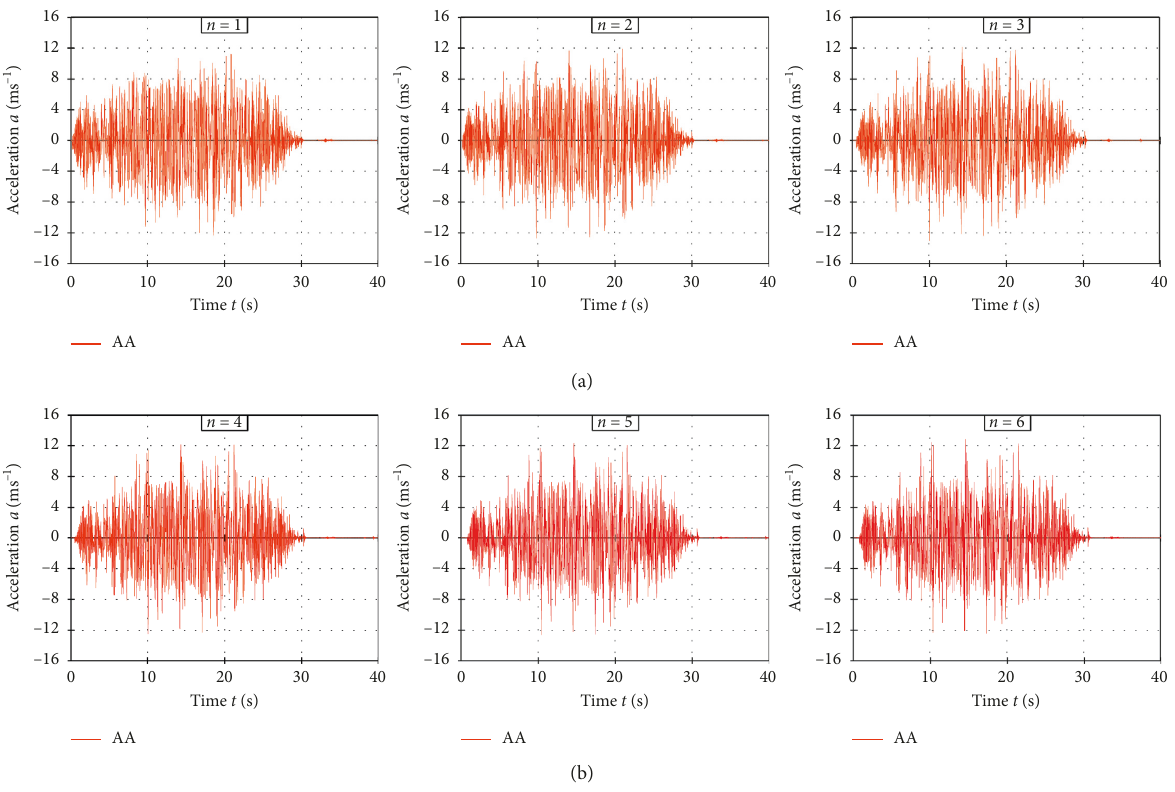
Figure 31: Horizontal acceleration a for repeated excitation